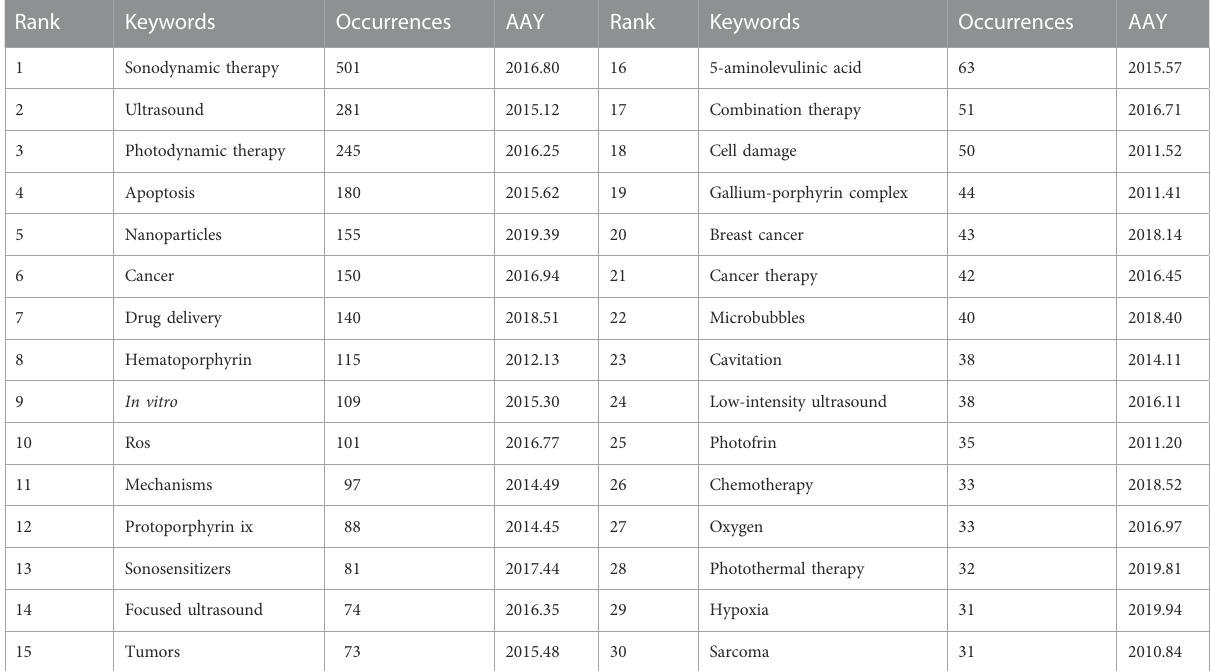
TABLE 3 The top 30 most frequent occurrences keywords in research scope of